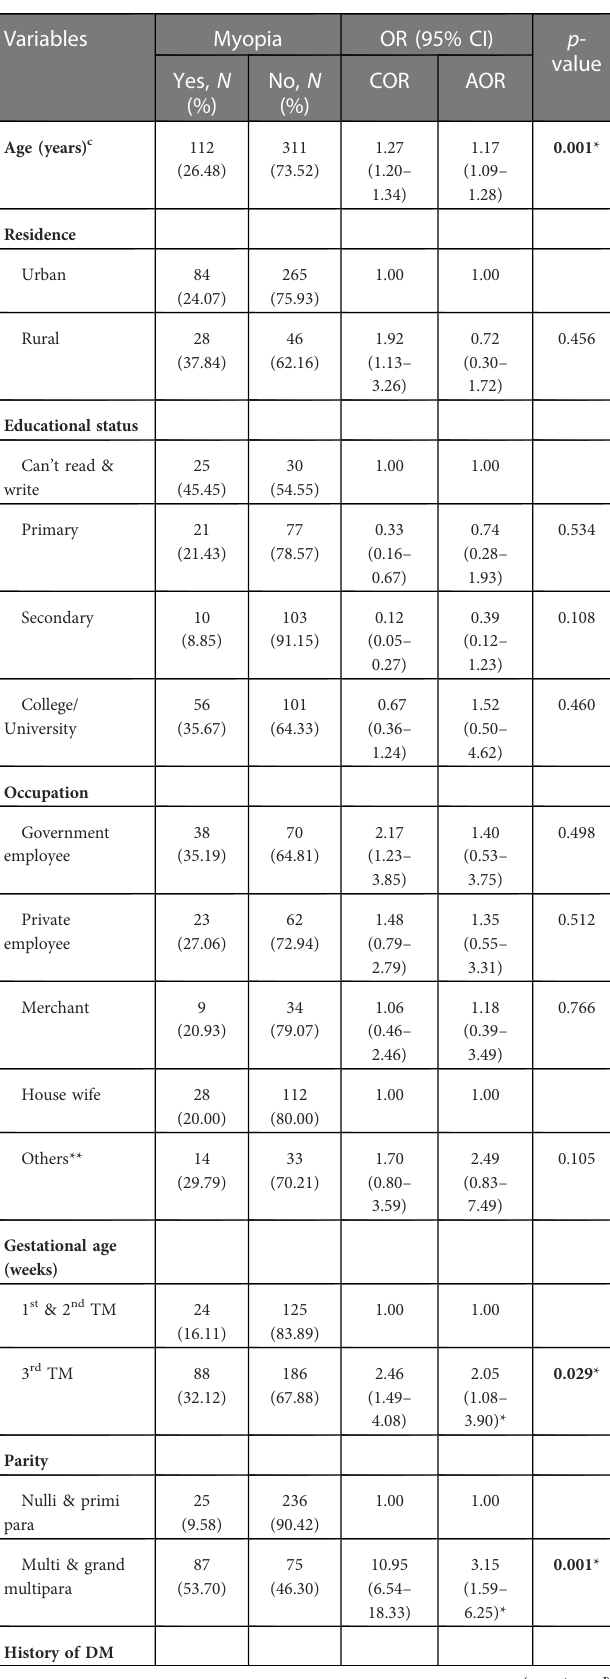
TABLE 3 Distribution of refractive error among pregnant women attending ANC units at governmental health institutions in Gondar District, Northwest Ethiopia, 2021 ( n =423).